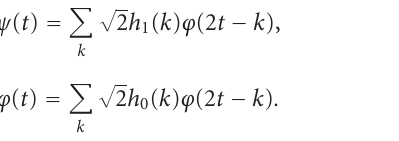
figure, filters F 0 ( z ) and F 1 ( z ) and the interpolator perform